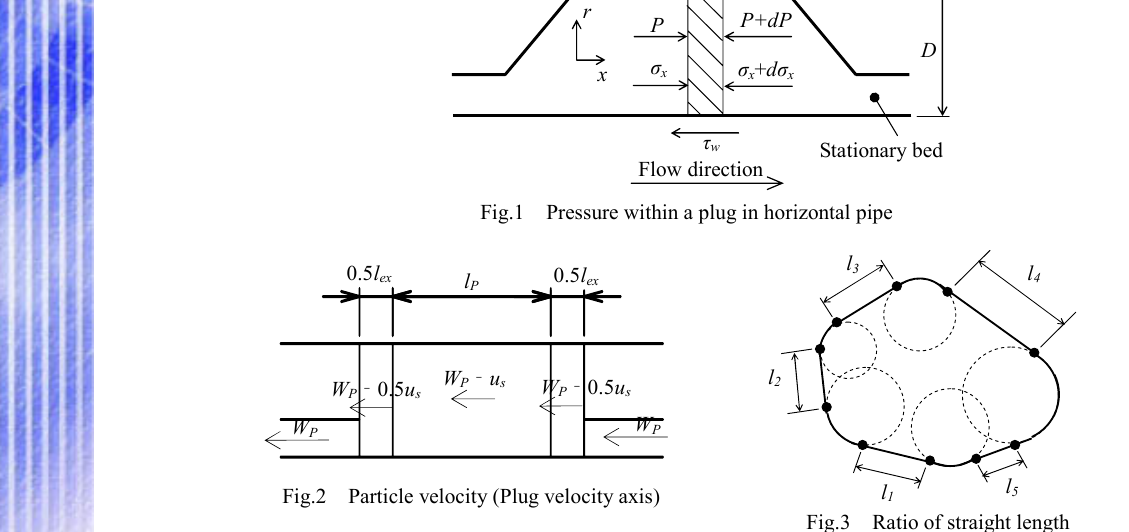
Fig.2 Particle velocity (Plug velocity axis)